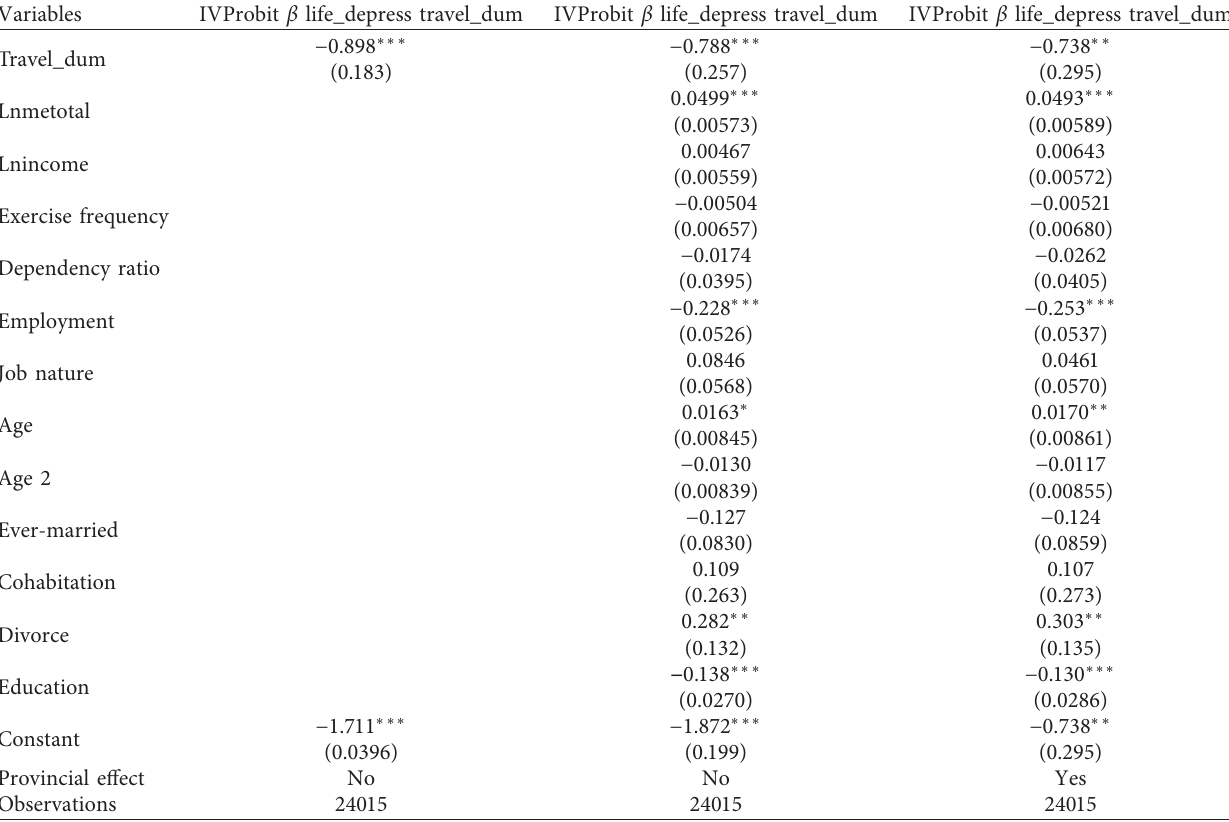
Table 3: Result of using instrumental variable to test the endogeneity of explanatory